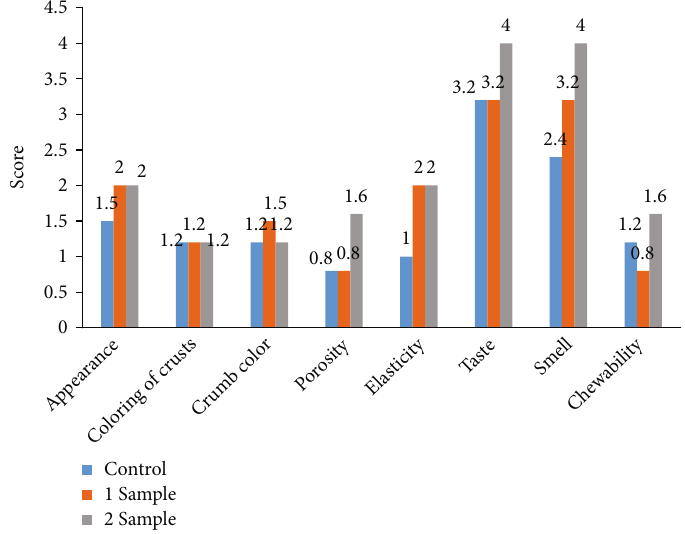
Figure 4: The results of the tasting evaluation of prototypes of bread with given weighting coe ffi